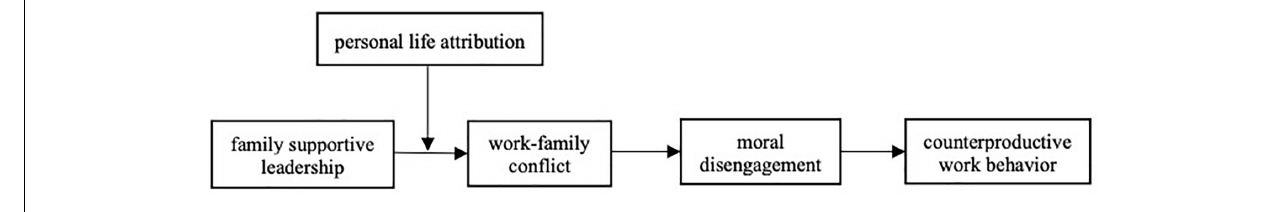
FIGURE 1 | The comprehensive